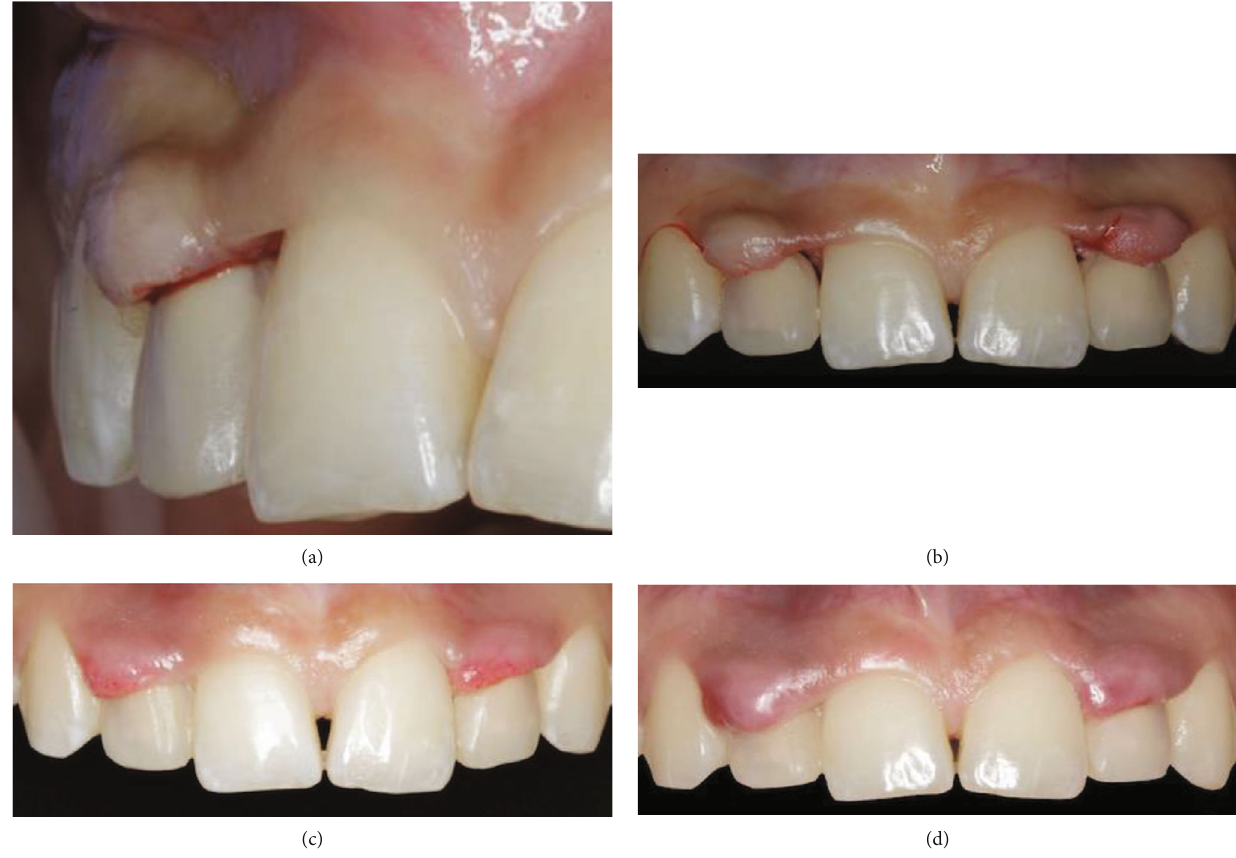
Figure 3: (a) The keratinized tissue moved from the occlusal side and was sustained by the augmented emergence pro fi le of the crown. (b) Peri-implant mucosa formation and gingival adaptation along with the emergence pro fi le of the crown restoration: in fl ammatory phase with the soft tissues sustained by the immediately placed crowns. (c) Soft tissues at four days of follow-up with minimal in fl ammation. (d) Soft tissues appeared in fl amed and elongated in a more coronal position at one week of